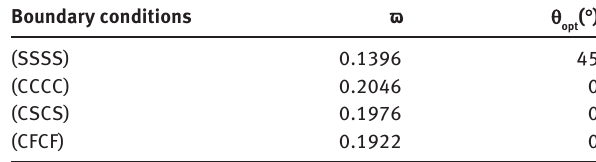
Table 3 Effect of a/b ratio on the optimum fiber orientations for simply supported laminated spherical shells.